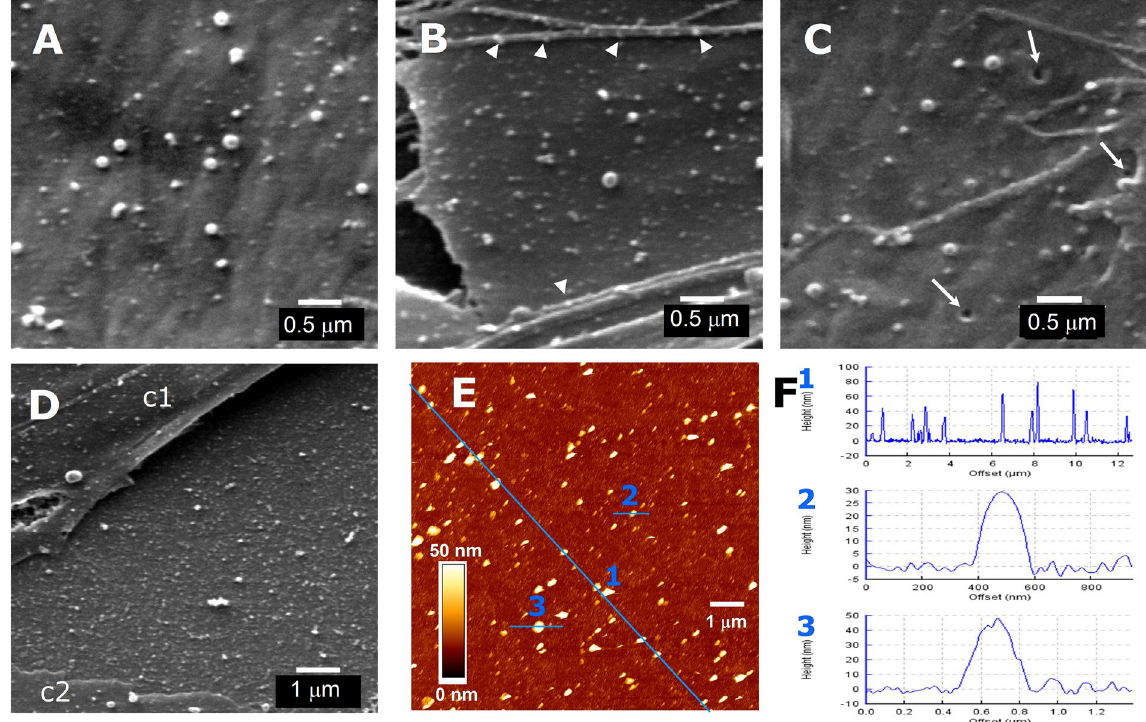
Figure 4. Scanning electron microscopy (SEM) images of protrusions and pits on ADSC surface and of EVs released by these cells. ( A , B ) Fields of ADSC surface showing protrusions of various sizes in control conditions ( A ) or 1 h after addition of 0.5 mM progesterone ( B ). Arrowheads point to some protrusions on filamentous processes. ( C ) Pits (arrows) were occasionally observed at the cell membrane. ( D ) Dense deposit of EVs on the coverslip surface between 2 cells (c1 and c2). ( E ) AFM image of ADSC-released EVs attached to poly-L- ornithine-treated coverslip. ( F ) Height profile samples of EVs attached to the coverslip area depicted in E, along the traces indicated in blue as 1, 2 and 3, respectively. Scale for A, B and C: 0.5 µ m; for D and E: 1 µ m. For F: abscise, trace length in µ m (F2, in nm); ordinates, height in